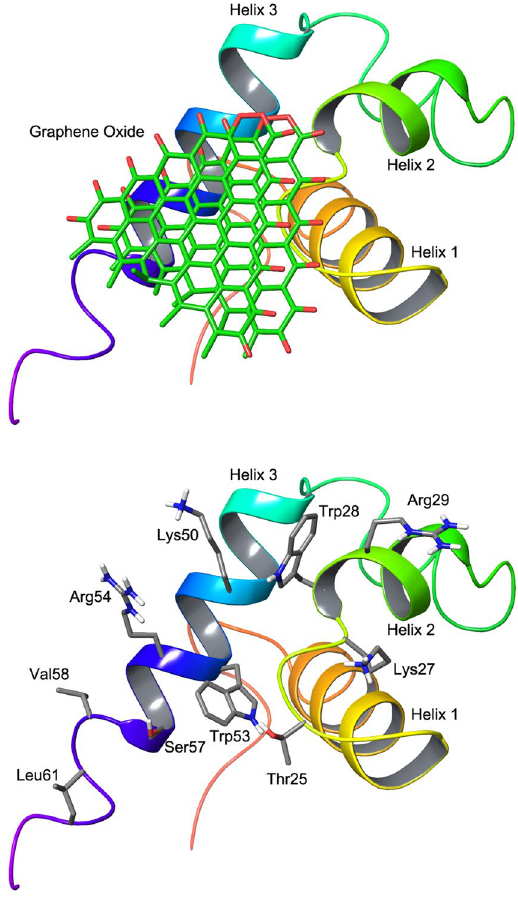
Figure 9. Predicted structure of telomere binding domain of AtTRB2 in complex with double-layer Graphene oxide ( a ) Binding pose of GO and ( b ) Binding site residues (within 5 Å of bound